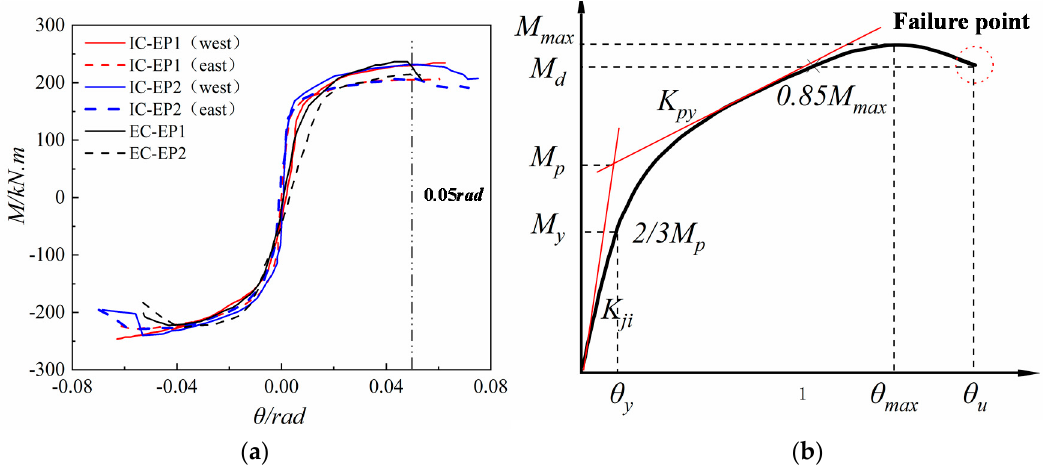
Figure 12. Moment ( M )–rotation ( θ ) envelope curves and key parameters definition of joints: ( a ) Skeleton curve; ( b ) Key parameters definition in the moment–rotation curve of connections. Table 5. Main test results.